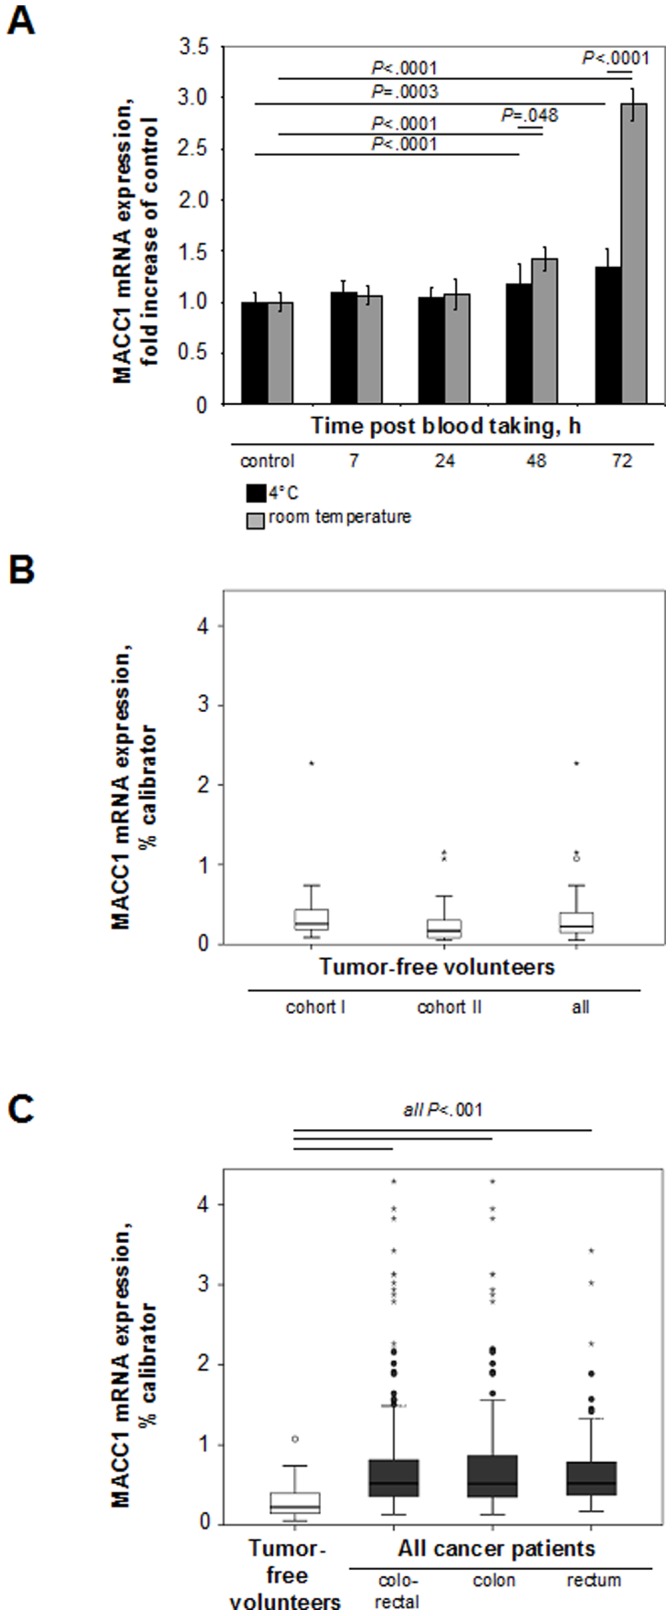
Circulating MACC1 transcript levels in plasma discriminate cancer patients from tumor-free volunteers.A. Plasma separation conditions for determination of circulating MACC1 transcripts. Plasma separation of samples from tumor-free volunteers (n = 12) was done immediately, 7, 24, 48, and 72 hours after taking blood, either from blood samples kept at 4°C or at room temperature. Subsequently, plasma was generated within the first 7 hours from 4°C-cooled blood. B. MACC1 transcripts in plasma of tumor-free volunteers (n = 54). No difference in MACC1 transcript levels were found in two independently analyzed cohorts of tumor-free volunteers (n = 34 and n = 20, respectively). C. MACC1 transcripts in plasma of all colorectal cancer patients (n = 312). All patient cohorts bearing colorectal, colon (n = 151), or rectal (n = 161) cancer expressed significantly higher MACC1 transcript levels than tumor-free volunteers (P<.001 for all comparisons).